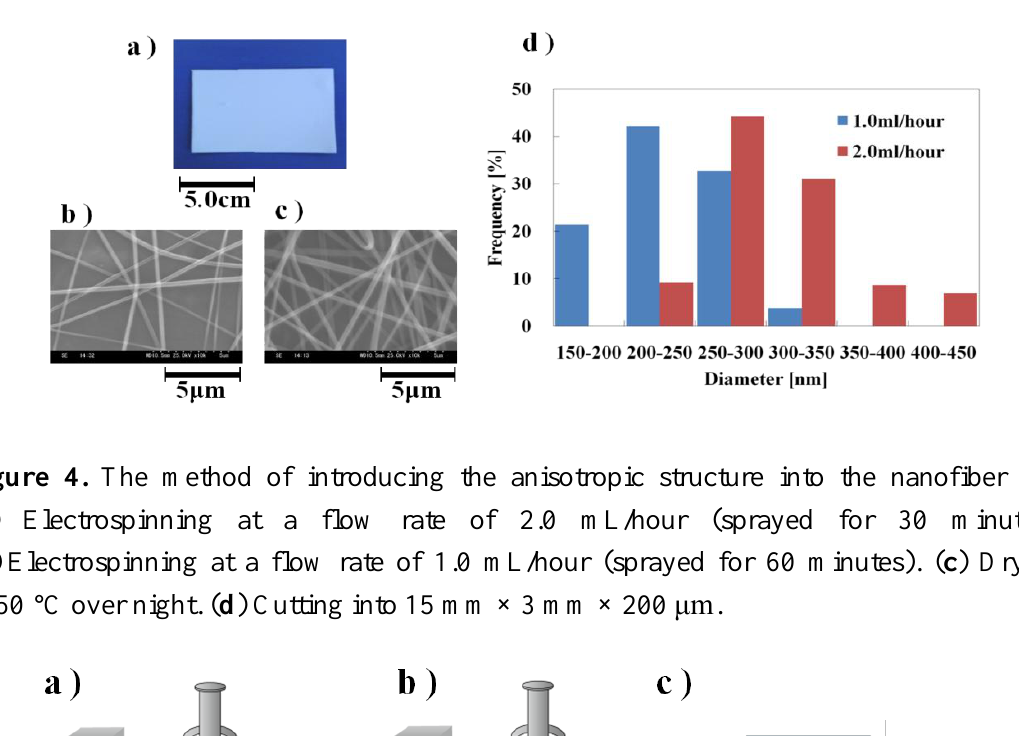
Figure 3. ( a ) An electrospun fiber sheet. ( b ) The SEM image of nanofibers at flow rate 1.0 mL/h. ( c ) The SEM image of nanofibers at flow rate 2.0 mL/h. ( d ) Distribution of